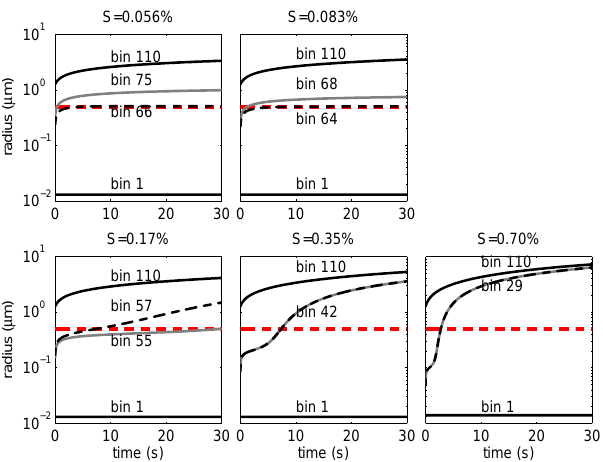
Fig. 4. Comparison between the average calculated CCN number concentration using the kinetic model (dot) and that using the equi- librium model (triangle). Different colours represent different su- persaturations as before.